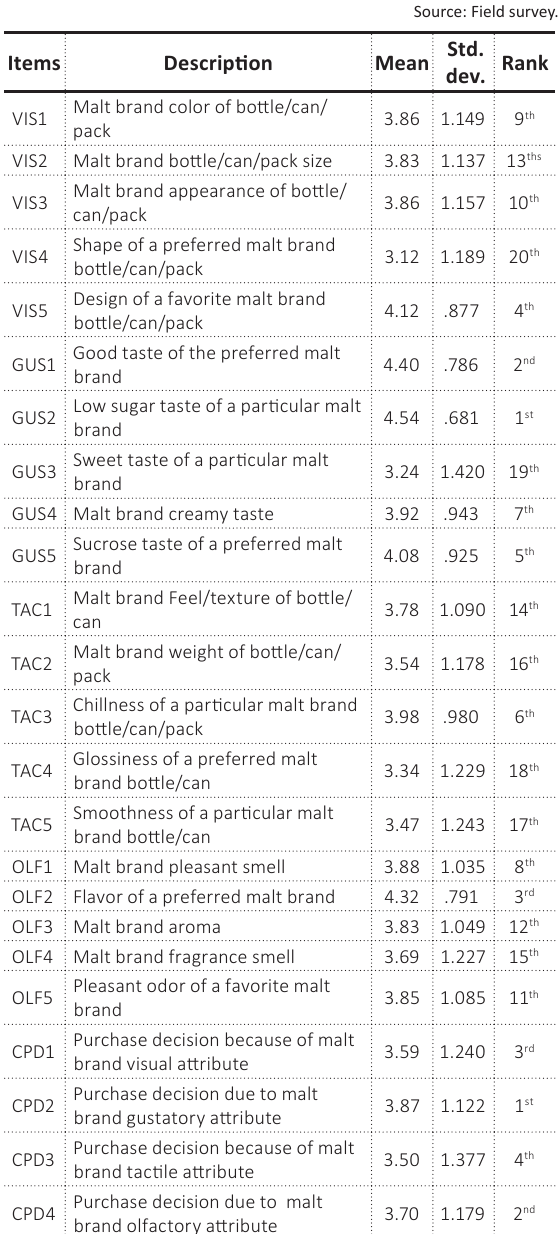
Table 2. Descriptive statistics